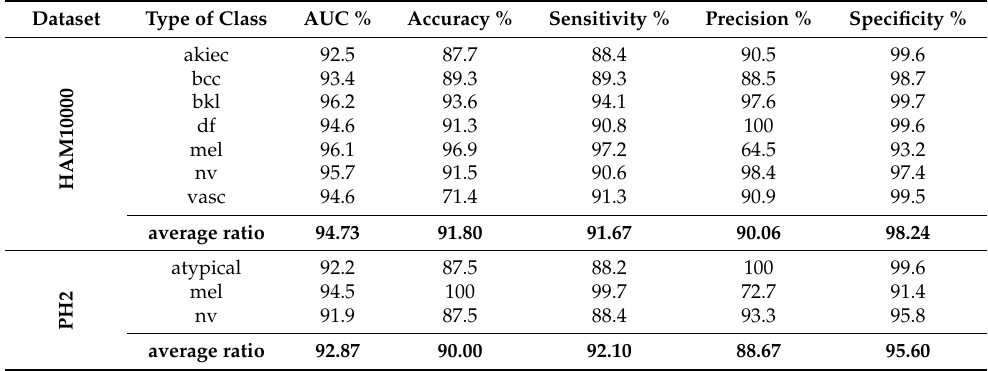
Table 3. Performance of MobileNet for dermoscopic image analysis to classify skin lesions in HAM10000 and PH2 datasets.